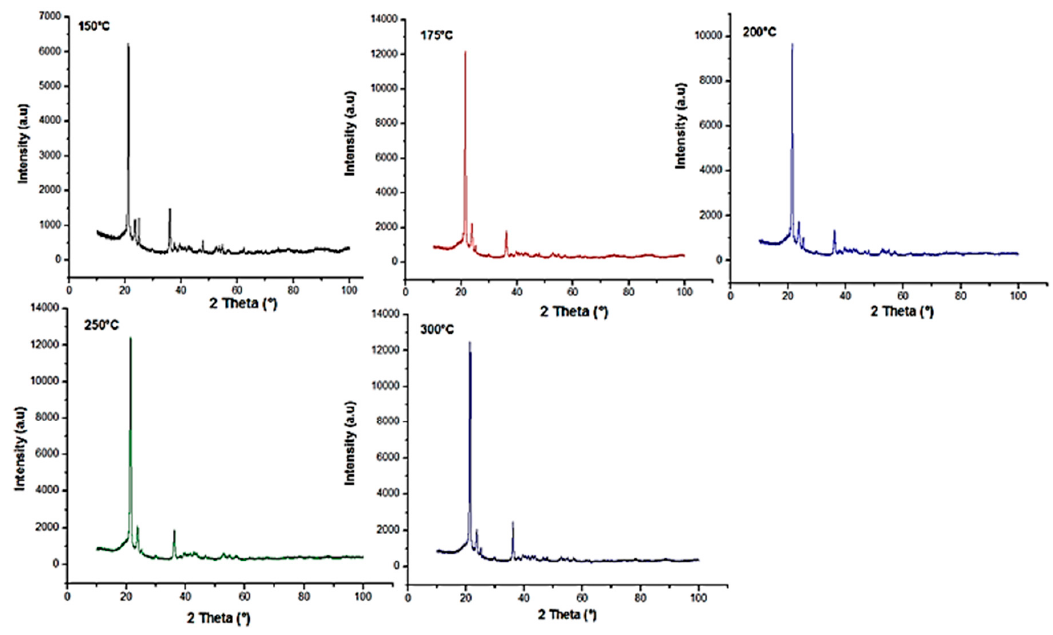
Figure 21. X-ray diffraction pattern for HDPE/TiO 2 nanocomposites fabricated at various barrel temperatures.